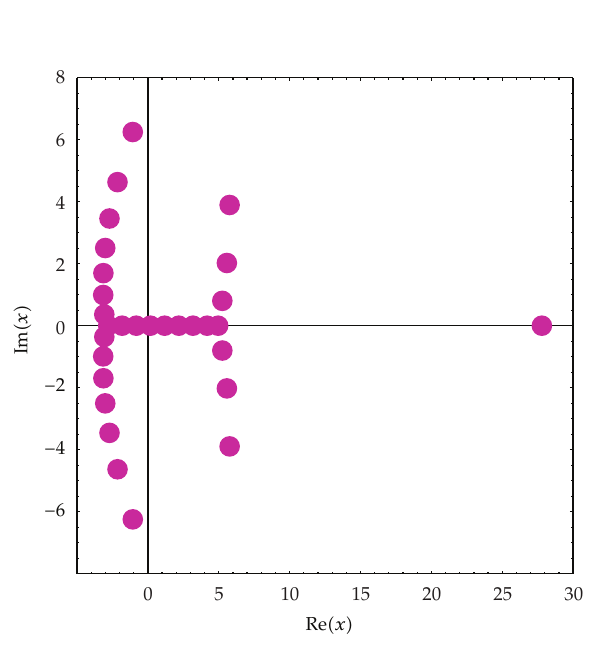
Figure 9: Zero of G 30 , 1 / 3 (cid:2) x (cid:3)